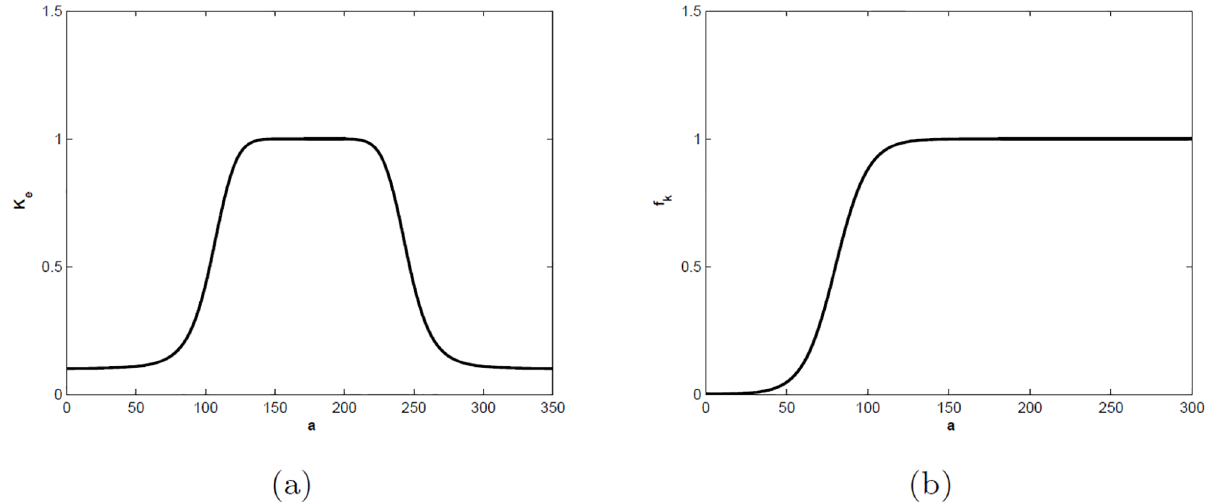
Fig 1. (a): The graph of the carrying capacity of beetles as a function of the age of trees K the age-related distribution of the fraction of trees killed per beetle in a successful attack f k ( a ) ( b 1 = 80, b 2 = 10).